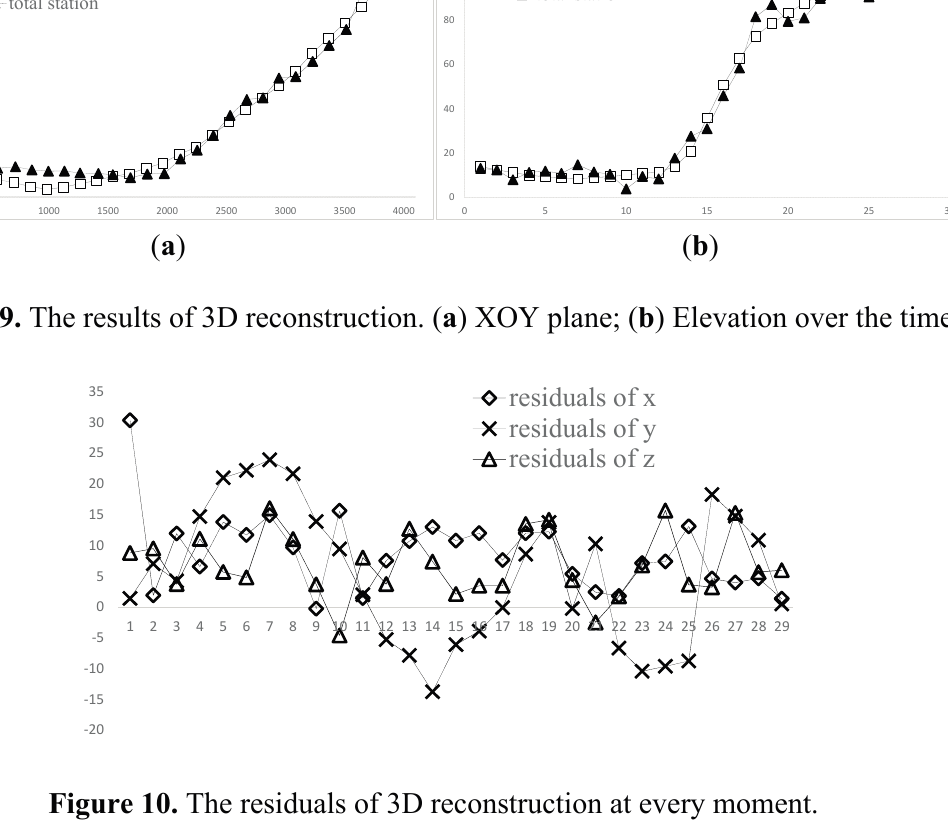
Figure 10. The residuals of 3D reconstruction at every